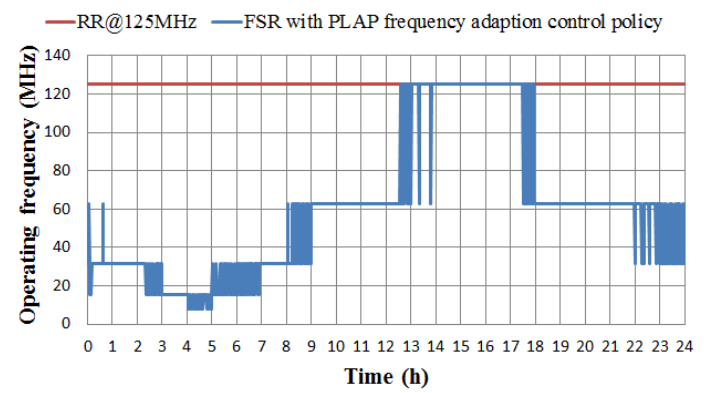
Figure 15. Operating frequency corresponding to the traffic trace in Figure